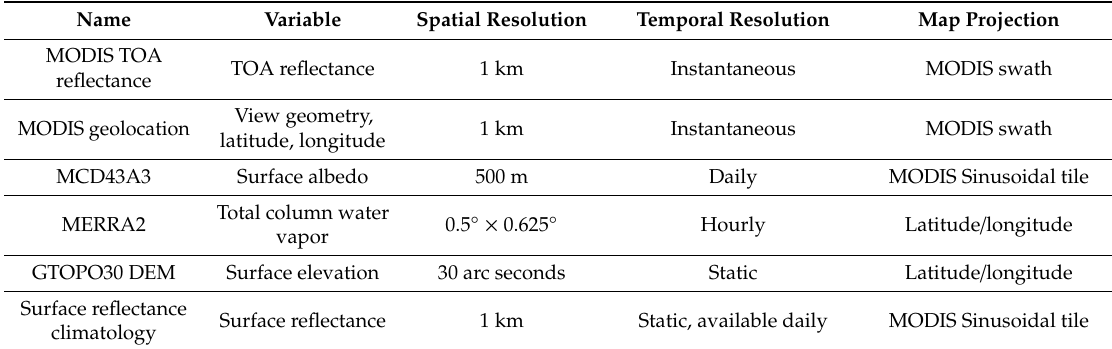
Table 1. Summary of the input data of the MODIS downward shortwave radiation (DSR) and photosynthetically active radiation (PAR) estimation